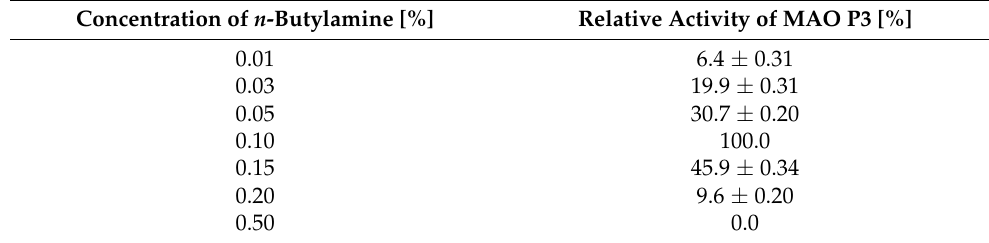
Table 1. Influence of amine concentration in the induction medium on MAO P3